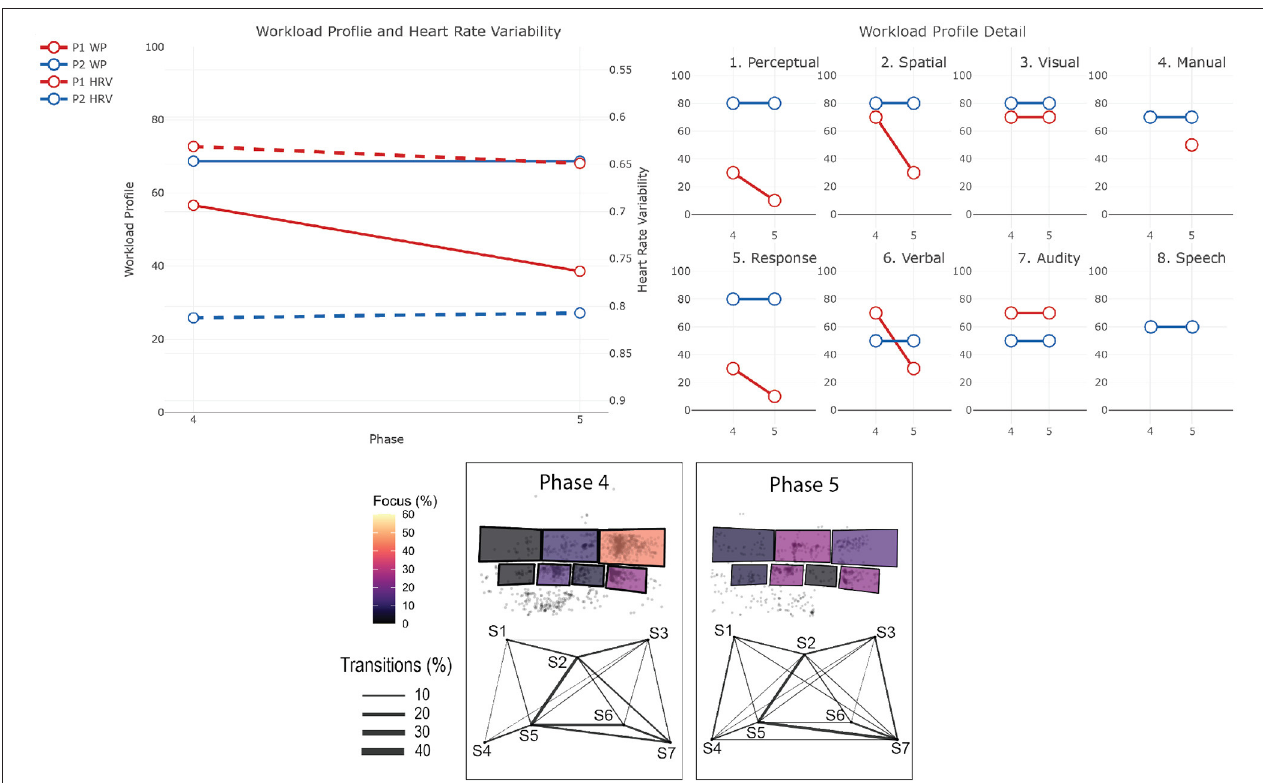
FIGURE 4 | Results for the second session of training 1. The top-left chart shows the evolution of the WP and HRV during the session for both participants (the axis of the HRV is inverted). The top-right chart shows the evolution of each criteria of the WP during the session for both participants. The bottom chart displays eye tracking data for P2 for each phase: at the top is the schematic representation of the operator’s workspace with a heatmap showing the amount of time the operator spent focusing on each screen; the bottom graph indicates the amount of transition between each of the screens with the thickness of the lines. The same organization is used in the following